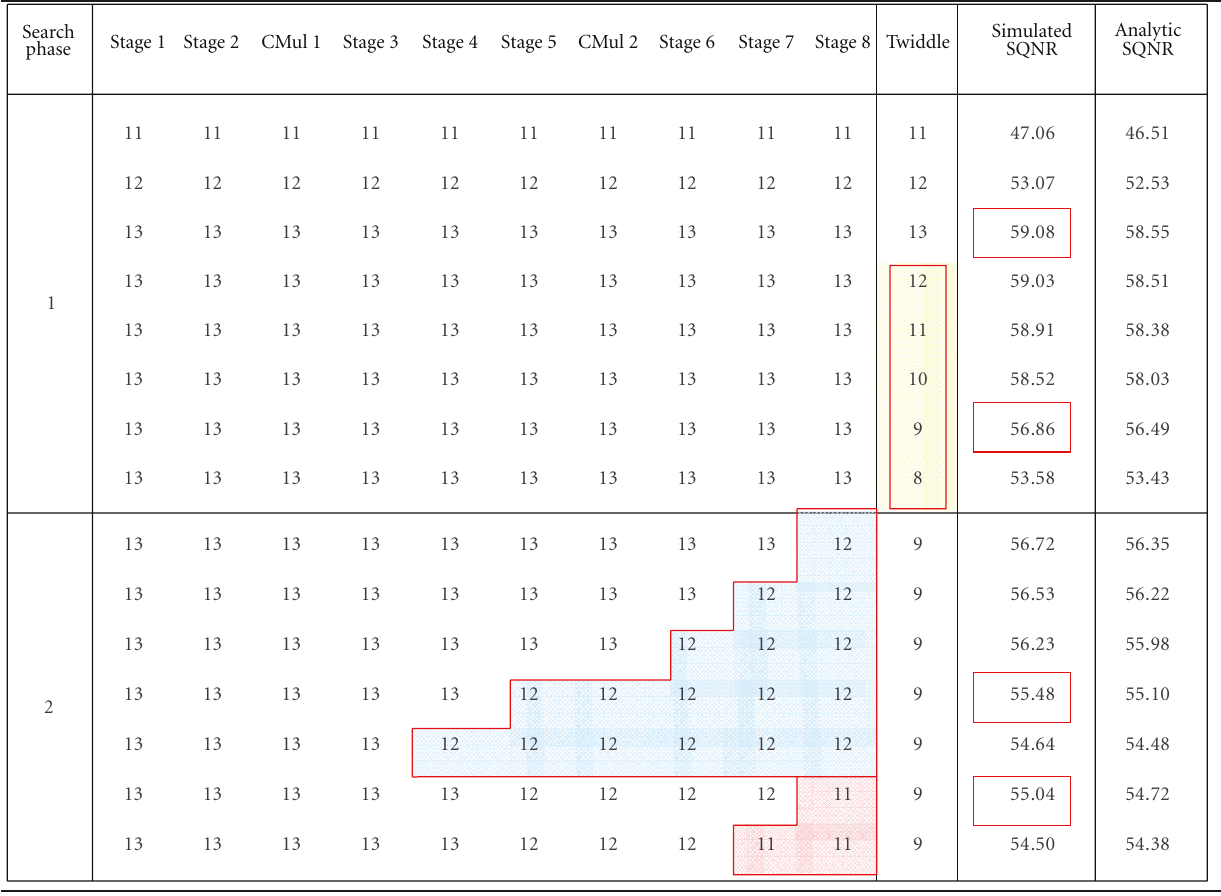
Table 3: One example of the proposed fractional-part word-length search